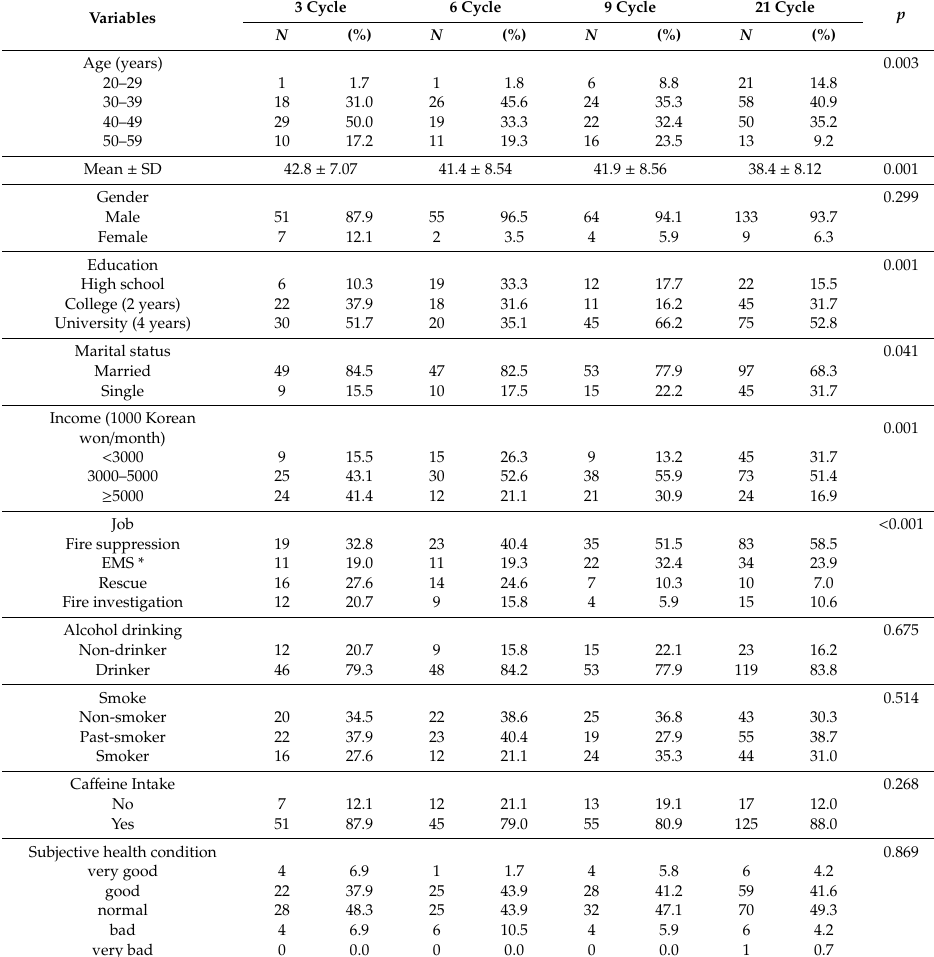
Table 1. Distribution of general demographic parameters by shift cycle ( N =